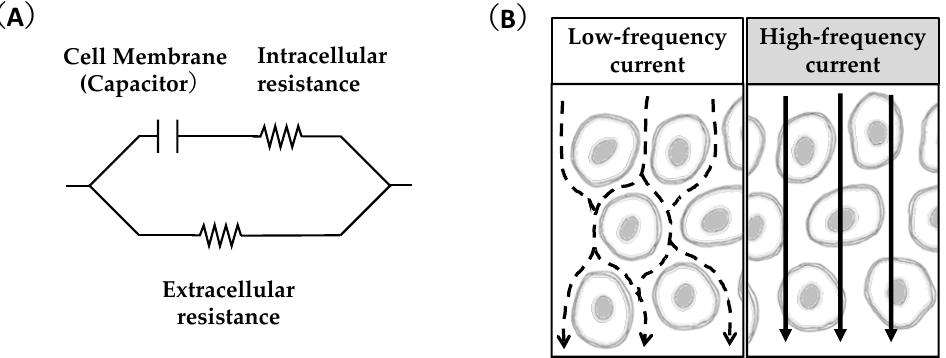
Figure 2. Equivalent circuit model of multi-frequency bioimpedance analysis ( A ) and the flows of low- and high-frequency currents ( B ) for a tissue.